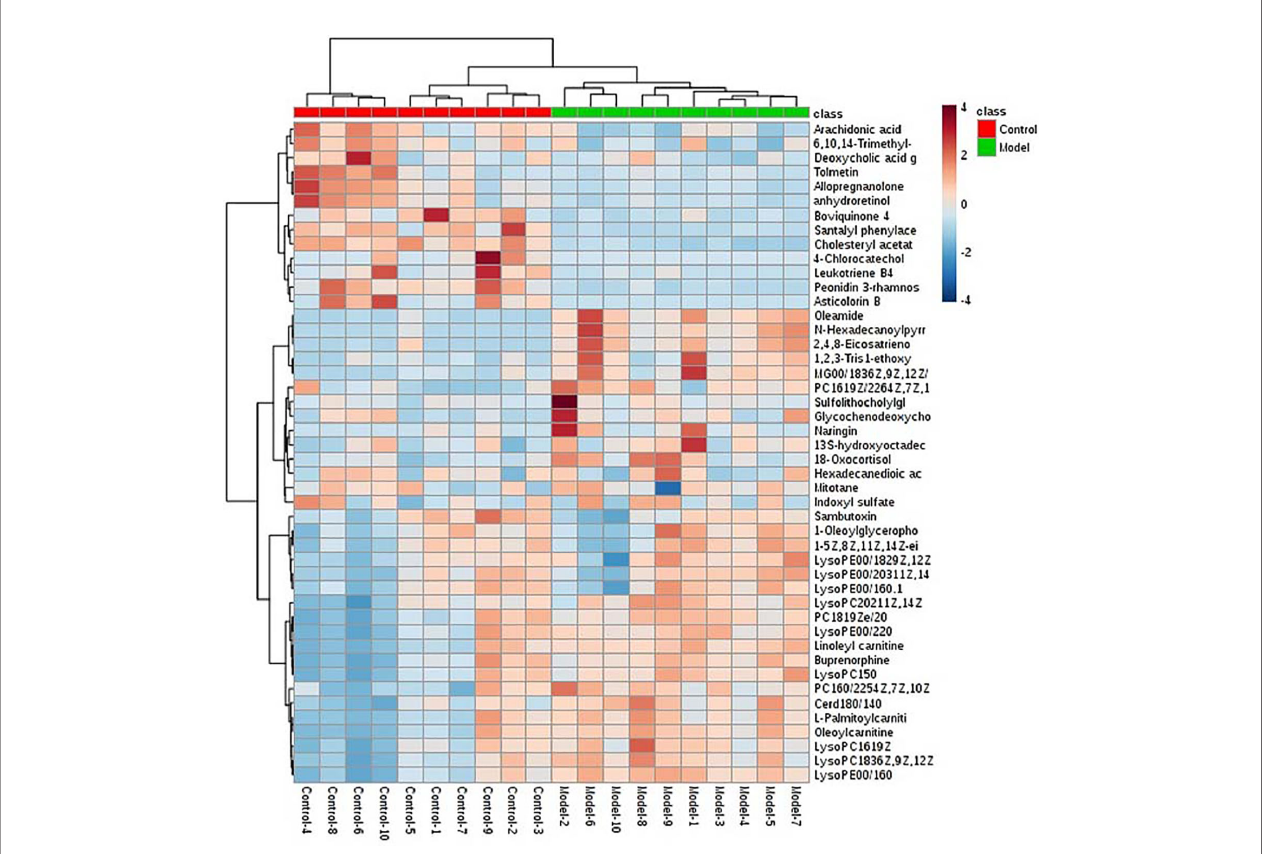
FIGURE 3 | Heat map analysis of 46 differential metabolites in model group rats and control group rats. The degree of change in the mark with different colors, each row represents a single sample, and each column represents a metabolite. Top red represents the control group and the green represents the model